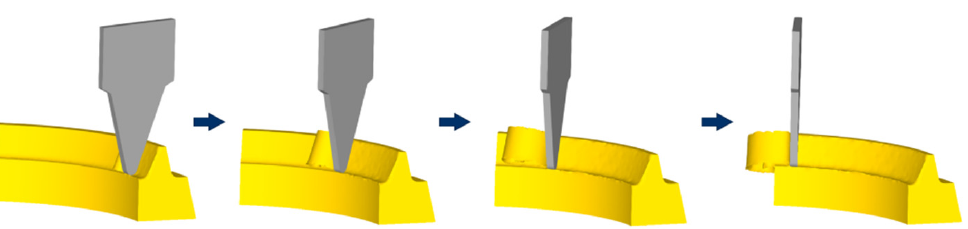
Figure 8. The whole process of single tooth cutting.